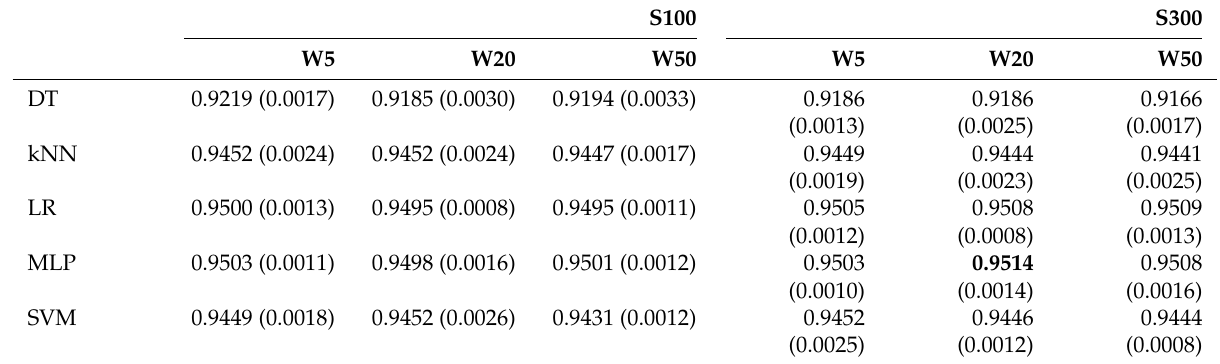
Table 2: Supervised learning WSD accuracies (standard deviations) with word embeddings as global features.